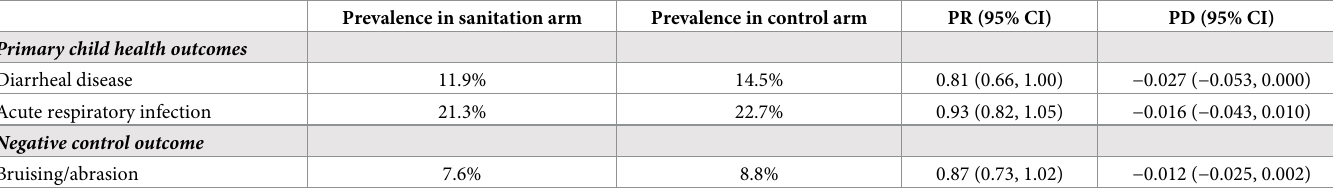
Table 1. Effects of the sanitation intervention on primary child health outcomes and negative control